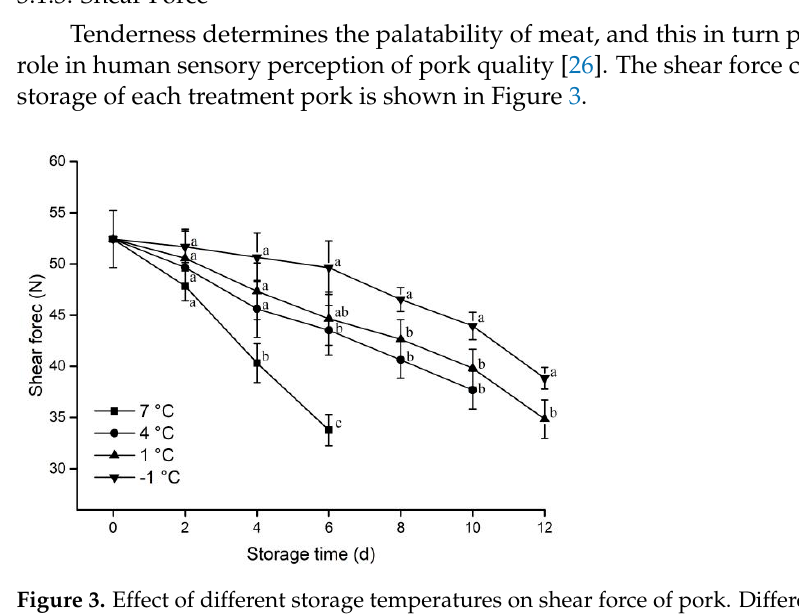
Figure 2. ( a ) Effect of different storage temperatures on L* value of pork; ( b ) Effect of different stored temperatures on a* value of pork. Different lowercase letters (a − d) indicate significant difference (p < 0.05) between each treatment on the same storage time.